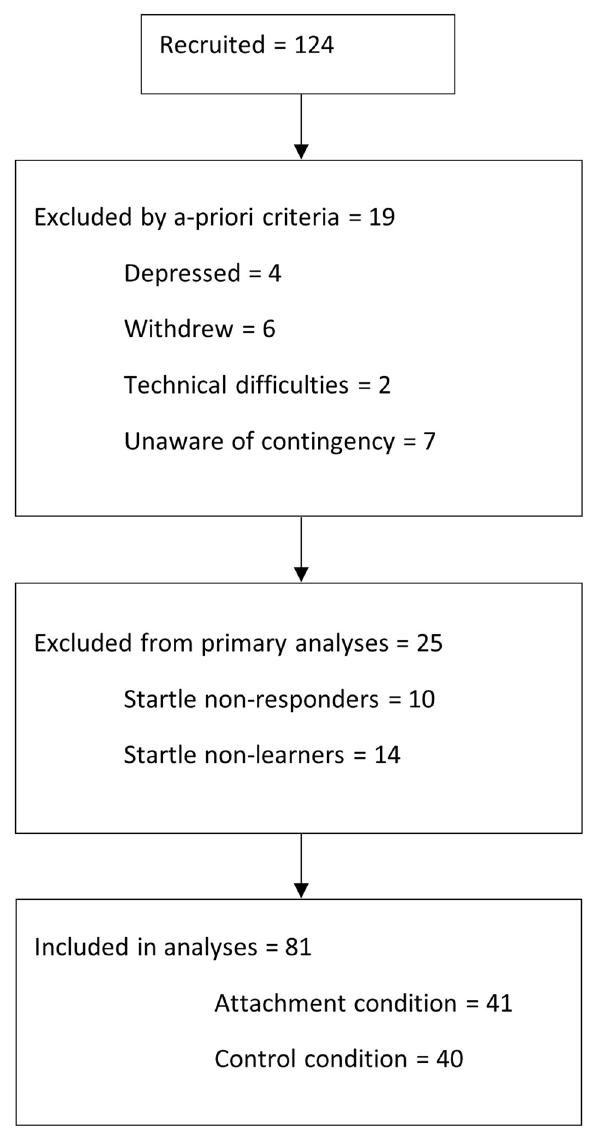
Fig. 1 Consort diagram of participants excluded. Participants excluded because of withdrawal, depression, technical dif fi culties, non-awareness of contingencies, and non-startler